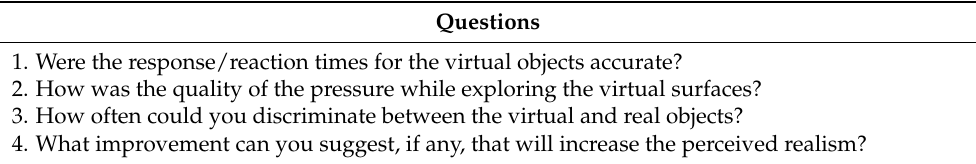
Table 1. Questionnaire for the post-experiment interview.